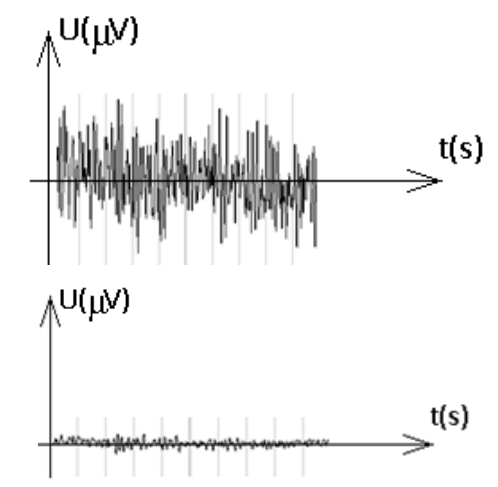
Fig 4 . Eyes blinking. Top – original, bottom – corrected.